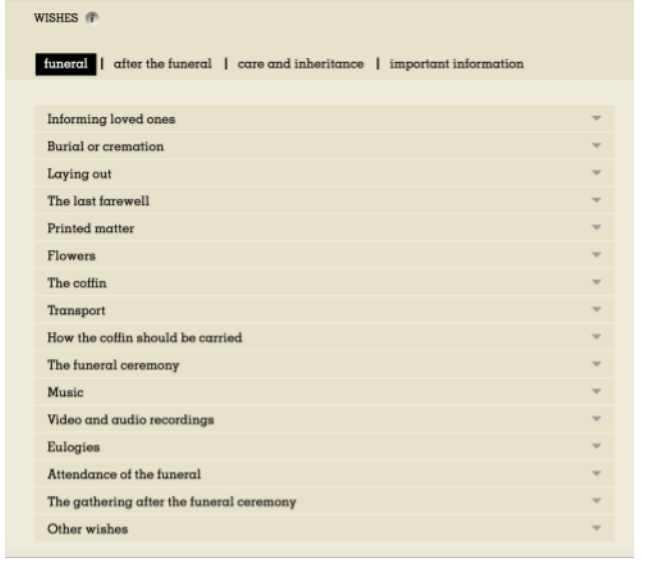
15. Afternote wishes page. Image taken from site: https://www.afternote.com/wishes/funeral.